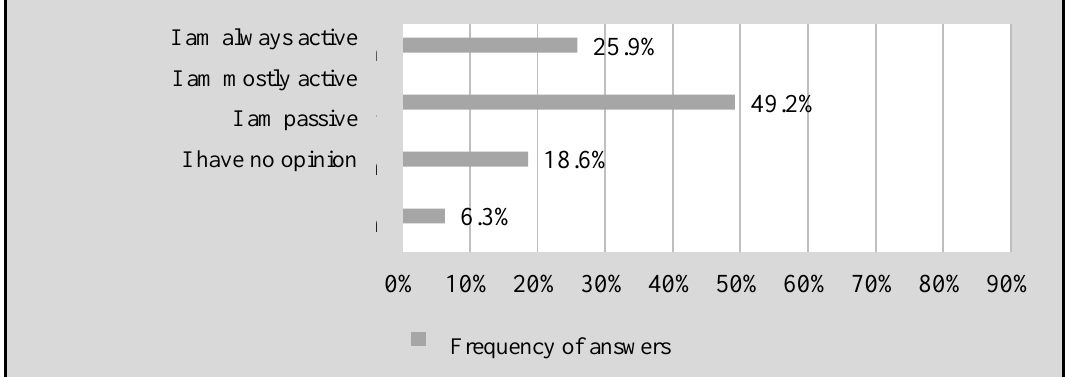
Figure 1. Why do you attend religious education classes? (Source: own study).